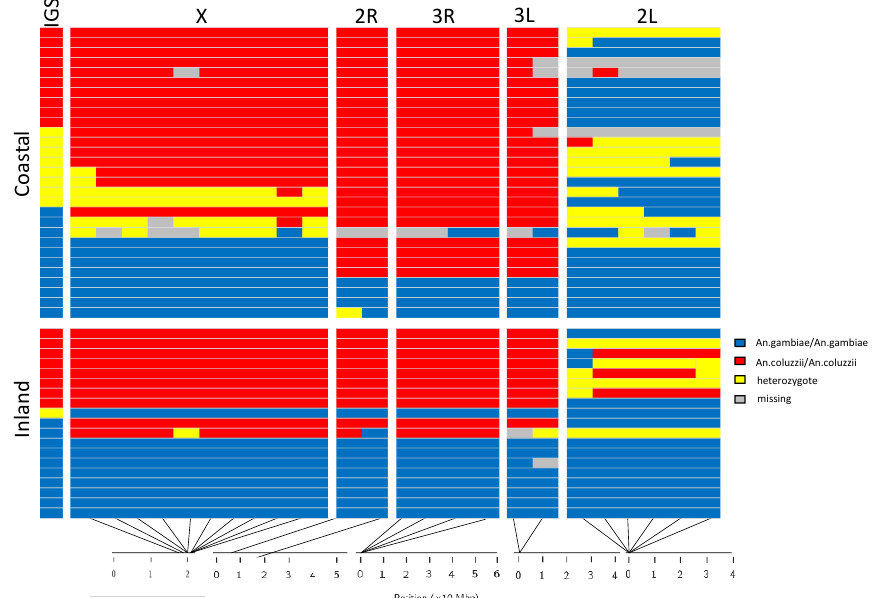
Figure 1. Results of multilocus genotyping of IGS- An. gambiae, IGS- An. coluzzii and IGS-hybrid specimens from the coastal (Ayame) and the inland (Petessou) villages in Côte d’Ivoire. Each row represents an individual mosquito and columns represent genotyped Ancestry Informative Markers [21]. The first column represents the species ID based on the IGS diagnostic marker. Below the figure the approximate position of AIMs on chromosomal arms. Blue = homozygote for An. gambiae specific alleles, red = homozygote for An. coluzzii specific alleles, yellow = heterozygote, grey = NA.